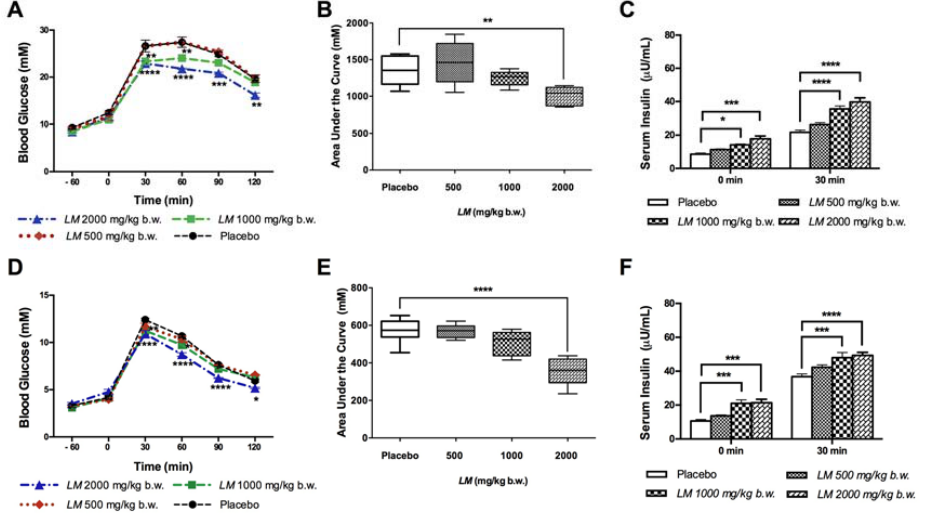
Figure 3. LM improves Glucose Tolerance and increases serum insulin. LM effect on glucose